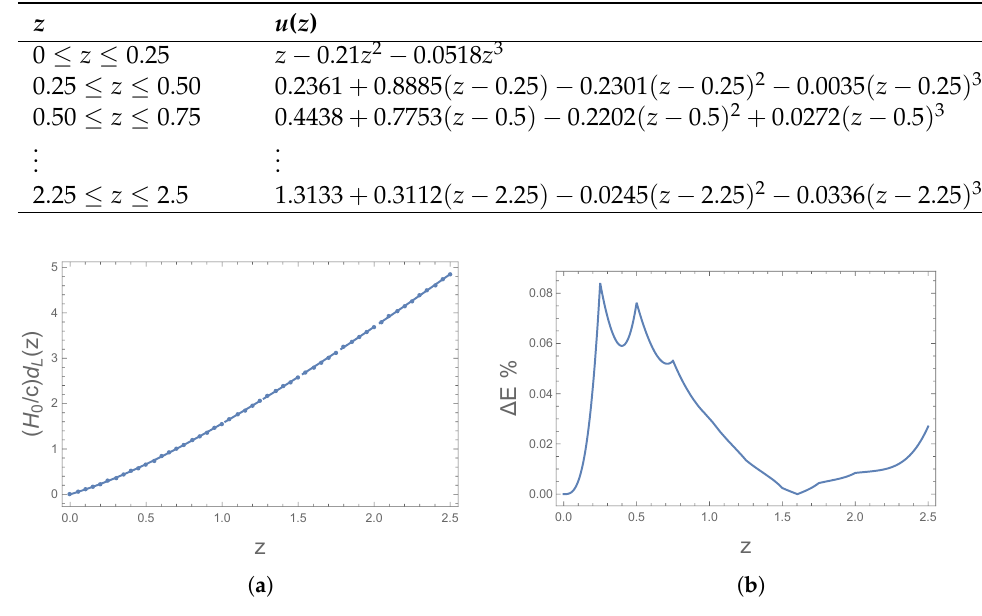
Figure 1. ( a ) The luminosity distance function ( H 0 / c ) d L ( z ) (solid curve) vs. the redshift z for the Λ CDM model with Ω m = 0.28. The corresponding numerical solution obtained by integrating (12) is also shown as plotted points for discrete values of z . ( b ) The absolute relative percentage error of the luminosity distance ∆ E vs. the redshift z